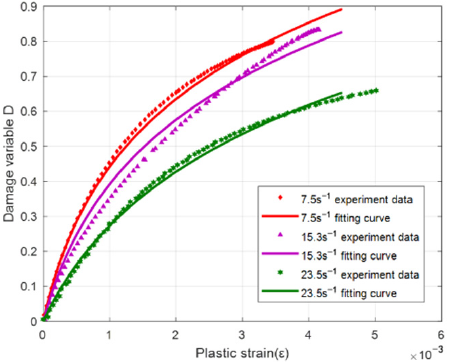
Figure 12. Comparison of damage variable fitting results.